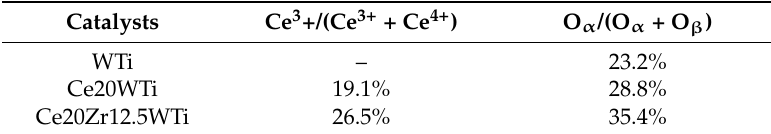
Figure 5. XPS spectra of O 1s core level for Ce x Zr y WTi catalysts. Table 2. The XPS results of the Ce x Zr y WTi